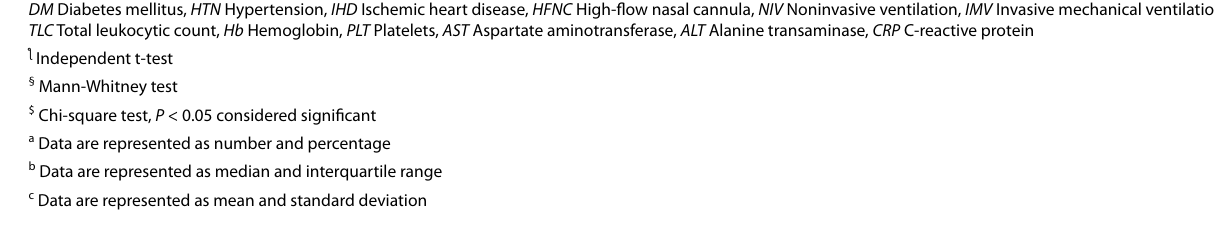
Table 5 The predictive value of elevated TLC and urea in COVID‑19 pneumonia mortality